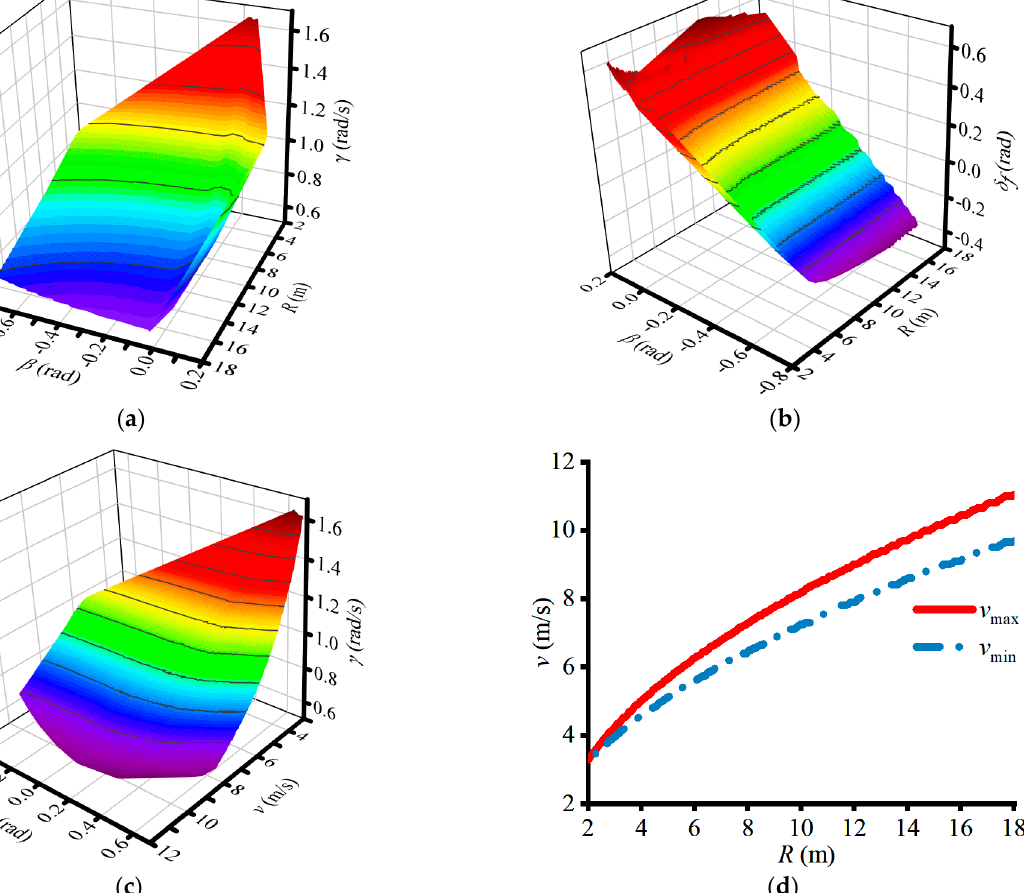
Figure 4. The motion mechanism analysis result in drift conditions: ( a ) The relation between the sideslip angle, the yaw rate and the radius; ( b ) the relation between the sideslip angle, the steering angle and the radius; ( c ) the relation between the steering angle, the yaw rate and the velocity; and ( d ) the velocity limitation.